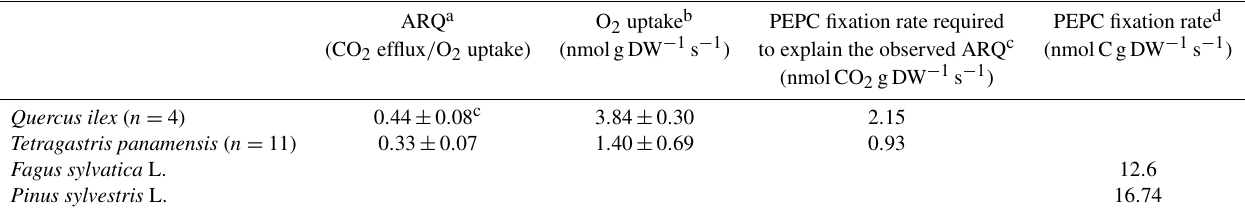
Table 2. Comparison between the calculated PEPC fixation rates required to explain measured ARQ in stem core incubations and reported PEPC fixation rates for young stems. ARQ a PEPC fixation rate required PEPC fixation rate